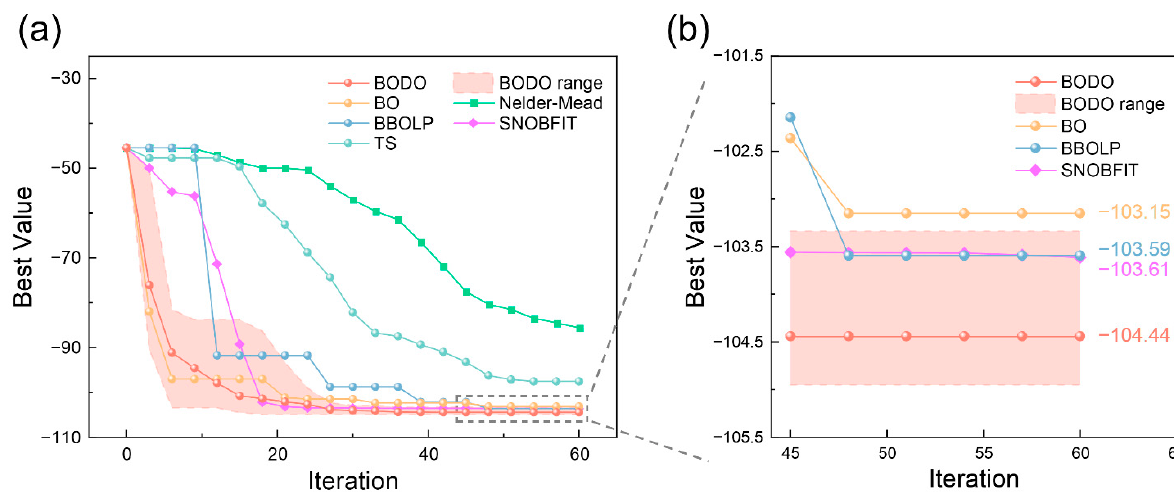
Figure 8. Optimization results of BODO and comparing algorithms on Summit SnAr. ( a ) average optimization results of different algorithms and BODO distribution range at each iteration. Non- deterministic algorithms (BODO, TS, and SNOBFIT) are run for 10 times. ( b ) Enlarged optimization results in the last few iterations. The batch size of BBOLP is set to 3.